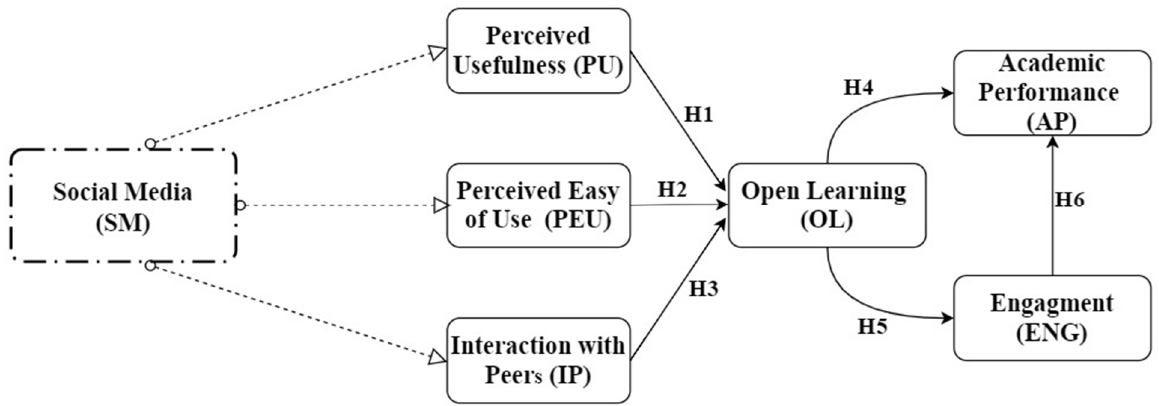
Figure 1. Conceptual model based on TAM and SCT.